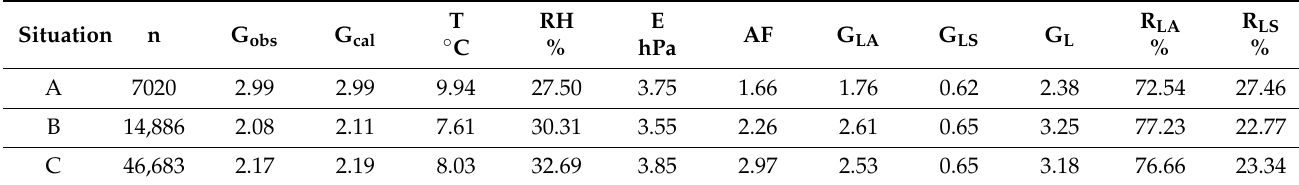
Table 6. Hourly averages of solar radiation (MJ m − 2 ) and meteorological parameters during Jan- measured dataset, situation B), and January 2007 to December 2020 (situation C).